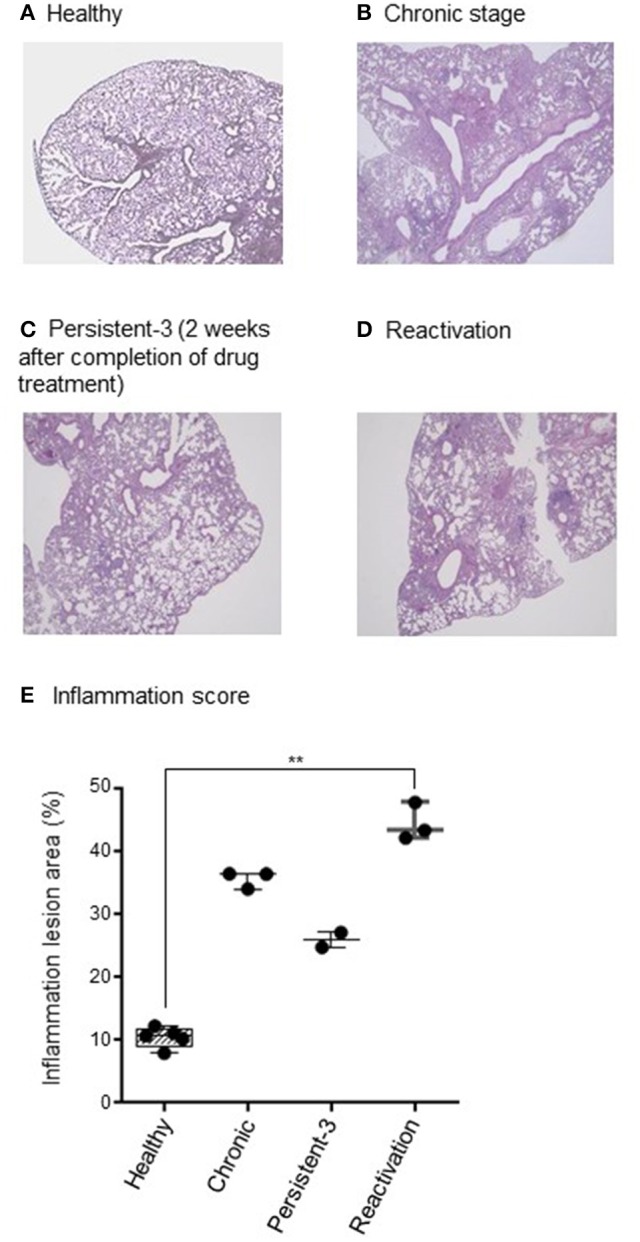
Histopathological findings. (A–D) One lung was fixed in phosphate-buffered formaldehyde and embedded in paraffin. Sections were stained with haematoxylin and eosin. Acid-fast Mycobacterium tuberculosis bacilli in the lung tissue were detected by Ziehl-Neelsen staining. The stained slides were observed under a light microscope (×40 magnification) and the representative picture are shown. (E) Lung inflammation lesions were evaluated by ImageJ software (National Institutes of Health, Bethesda, Maryland, USA). Results were represented as the percentage of area with lesions. N = 2–8 in each group. Each dot denotes each individual. One-way ANOVA was used for statistical analysis. **p < 0.01.